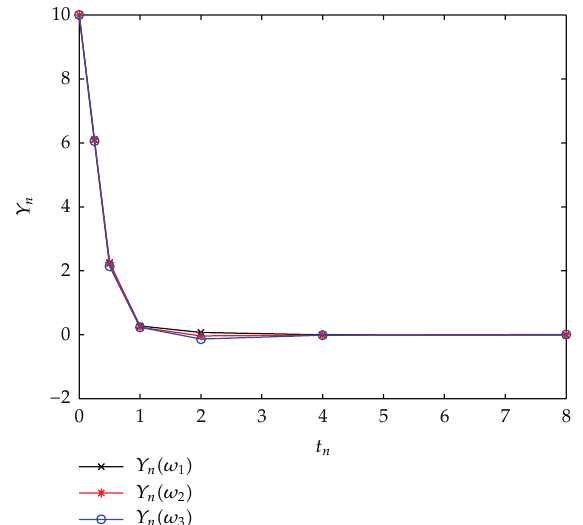
Figure 2: Almost surely asymptotic stability with x 0 (cid:7) 10 , t 0 (cid:7) 1 , m (cid:7)